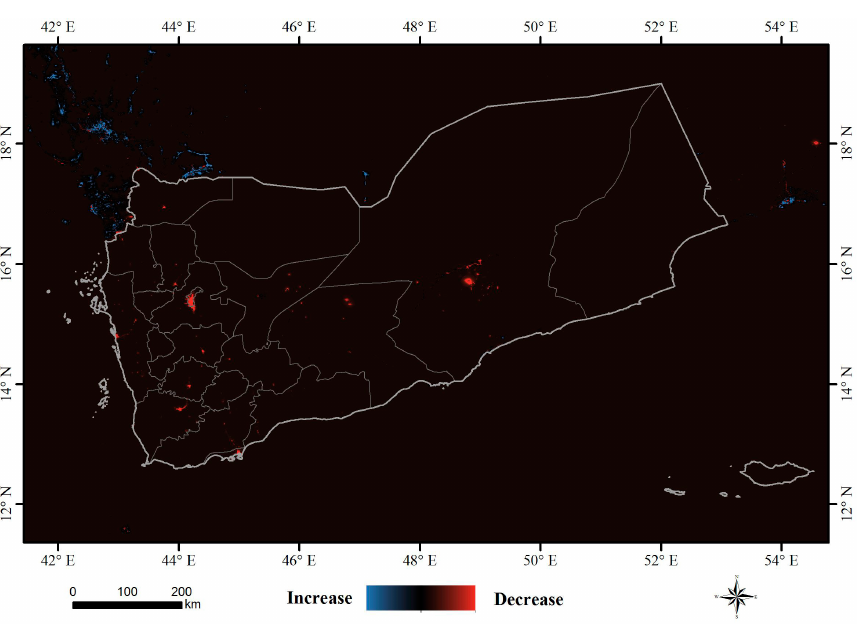
Figure 11. Change in nighttime light from April 2012 to March 2017 in Yemen